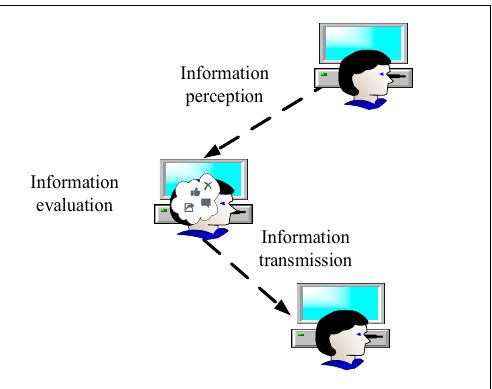
Figure 3. The process of information diffusion consists of three parts: information perception, information evaluation, and information transmission.